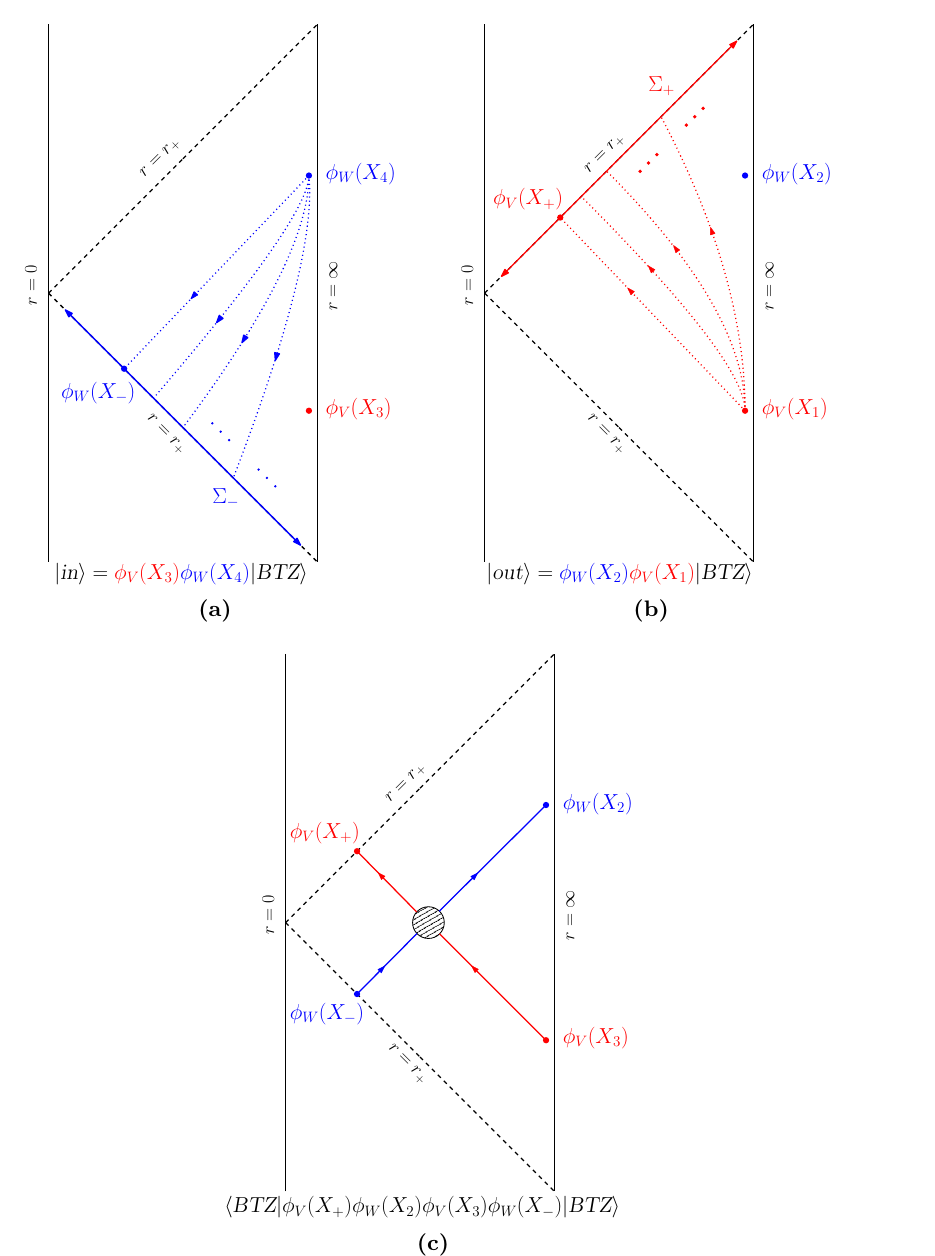
Figure 5. Steps involved in the derivation of formula (2.5) for the OTOC written as the state overlap h out | in i , illustrated in the case where the background geometry is an extremal BTZ black hole, i.e. | ψ i = | BTZ i . (a)-(b) The operator φ ( X ) ( φ ( X ) ) used to create the in-state (out- W 4 V 1 state) may be represented on the early (late) time slice Σ ( Σ ) by free propagation backward − + (forward) in time. The slices Σ and Σ are chosen to coincide with the past and future horizons, − + respectively. (c) The state overlap h out | in i reduces to time-ordered transition amplitudes involving all points X Σ ) and X Σ ) − ( X + ( X − ∈ − ∩ J 4 + ∈ + ∩ J 1